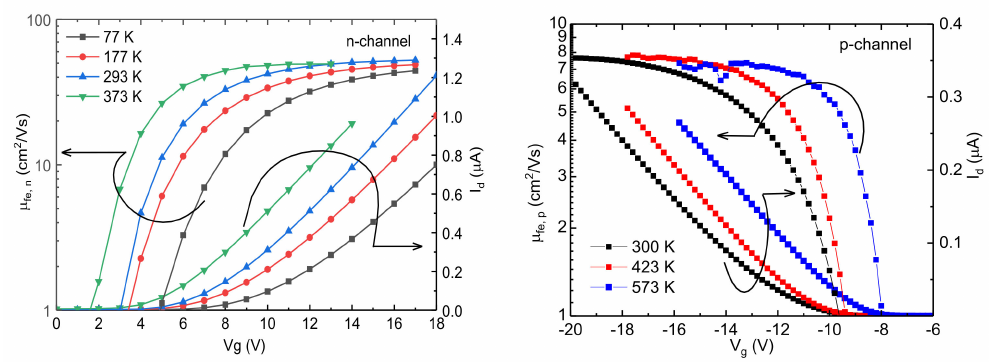
Figure 2. Field effect mobility of electrons and holes versus gate voltage at different temperatures for n- and p-channel 4H-SiC MOSFETs. For n-channel MOSFETs, channel width/length was 60 µ m/600 µ m, oxide thickness was 60 nm, V ds was set to 0.4 V, and temperature was varied from 77 to 373 K. For p-channel MOSFETs, channel width/length was 200 µ m/200 µ m, oxide thickness was 55 nm, V ds was set to 0.1 V, and temperature was varied from 300 to 573